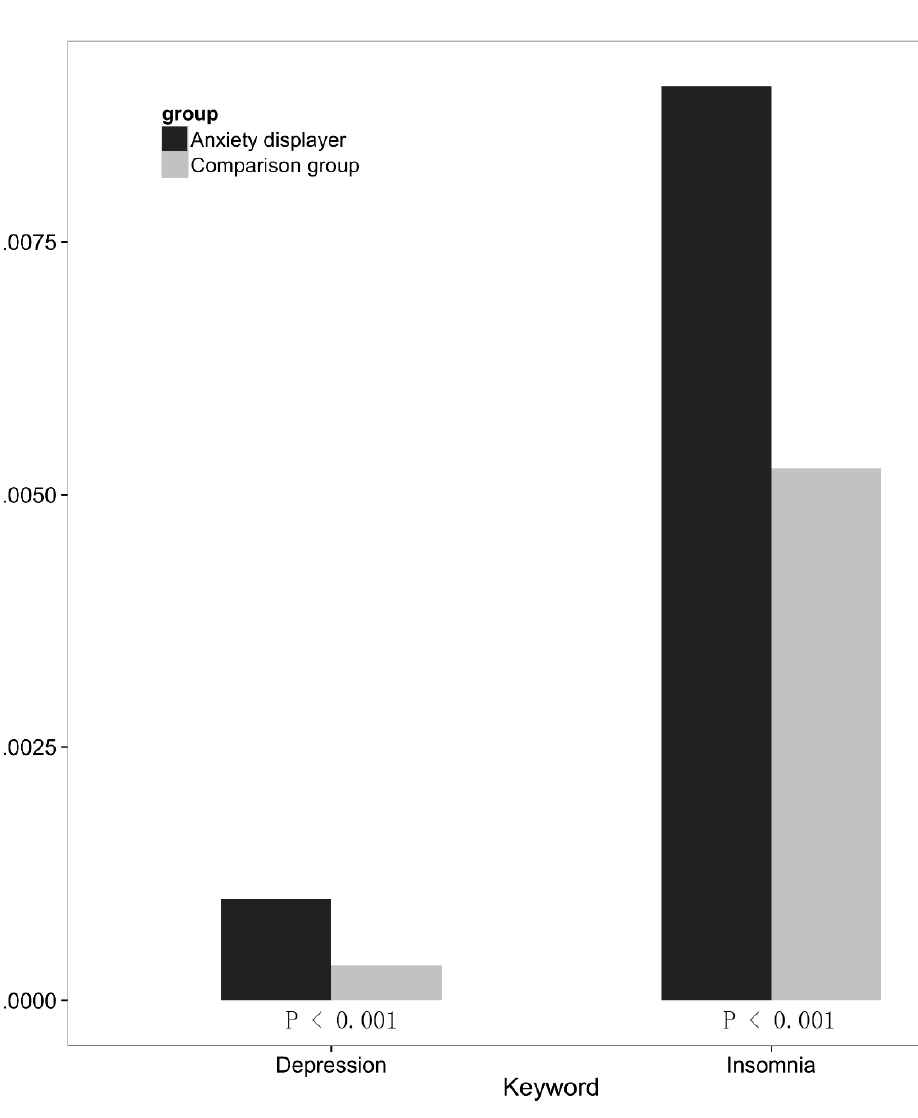
Figure 4. Relationship with depression and insomnia.